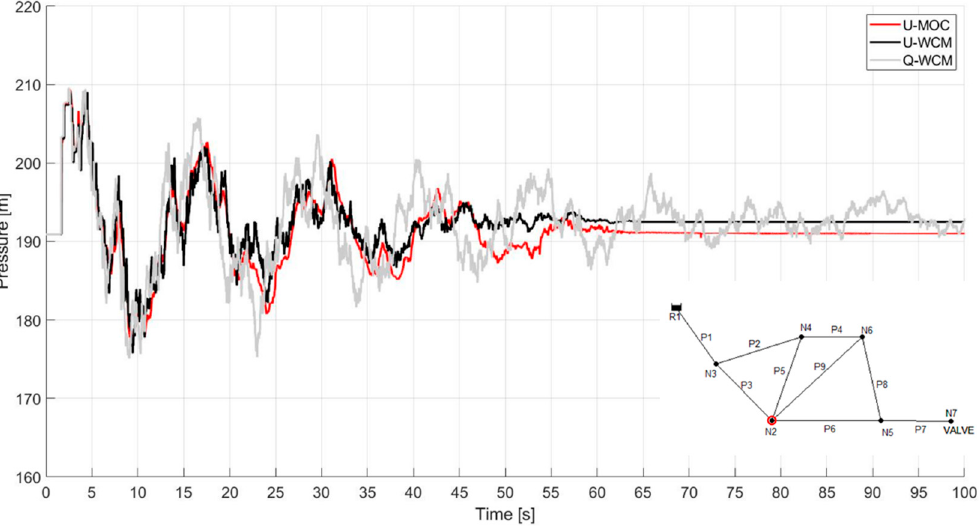
Figure 8. Transient response at node 2 in the second case study. U-MOC, U-WCM, and WCM in red, black, and gray, respectively.